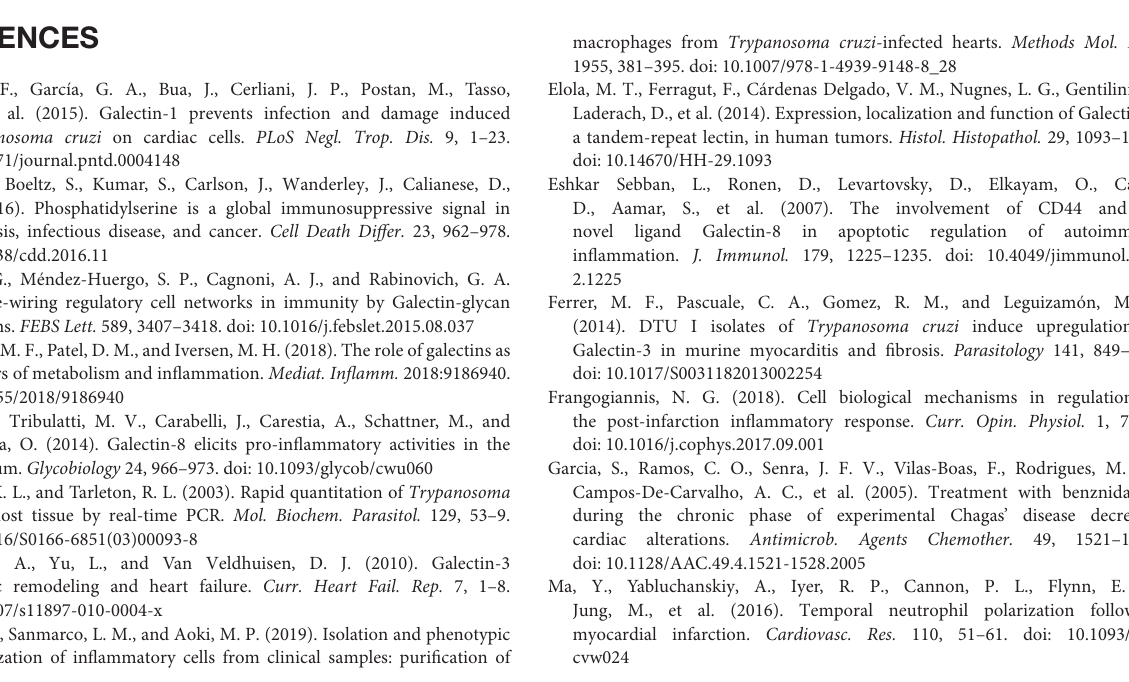
Supplementary Figure 1 | Representative gating strategy for illustrating CD19 + B lymphocytes and CD4 + and CD8 + T lymphocytes in heart tissue. Supplementary Figure 2 | Representative gating strategy for illustrating CD11c + F4/80– dendritic cells and CD11b + Ly6C + Ly6G– monocytes in heart